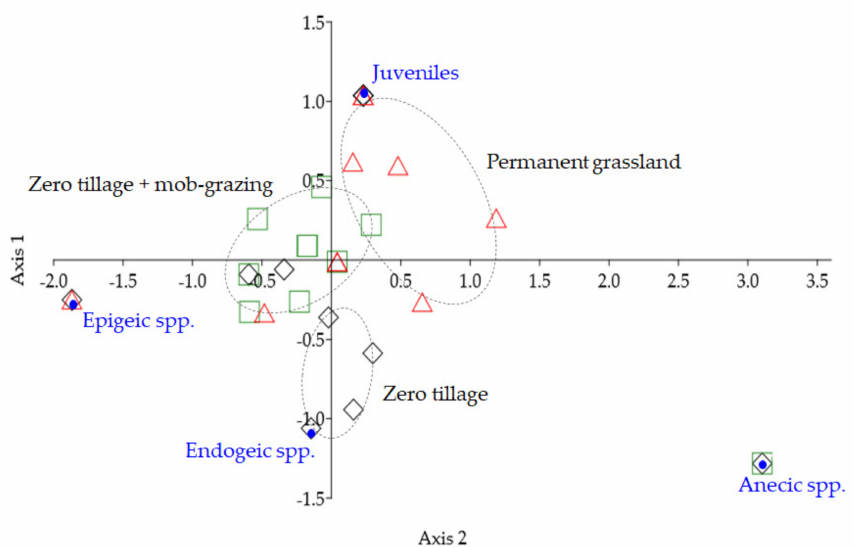
Figure 4. Canonical Correspondence Analysis of earthworm functional group, % soil organic matter and % soil moisture for three treatments ( : zero tillage; : zero tillage + mob-grazing; : permanent grassland), n = 10 per treatment. Axis 1: Eigenvalue 0.0075, 96.6% variation; Axis 2: Eigenvalue 0.0003, 3.4%